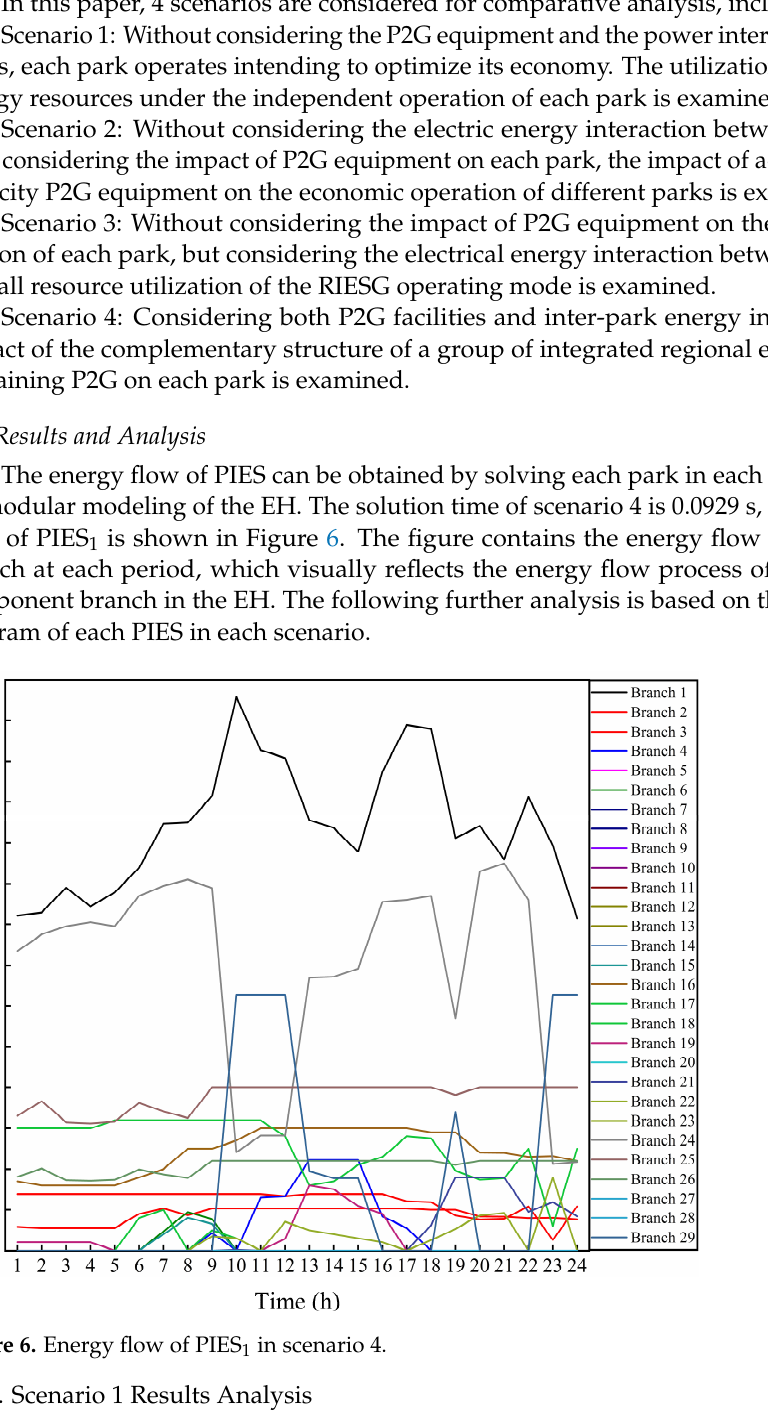
Figure 7. Power surplus and shortage of each PIES. As can be seen in Figure 7, PIES 1 has a large surplus of renewable energy to meet its own load demand, due to the abundant wind and solar resources inside the park. It is worth noting that the surplus renewable energy cannot be consumed under the independ- ent operation mode. PIES 2 is a single wind power generation system, and PIES 3 is a single photovoltaic power generation system. Since the renewable energy resources in the park are inadequate to supply the energy demand of the system itself, the situation reflects the time difference of scenery resources, in which PIES 2 is a wind power generation system, and the power shortage is larger in the daytime when the wind power generation is small, and PIES 3 is a photovoltaic power generation system, and the power shortage is larger at night. PIES 4 is a combination of wind and solar power generation systems. As the shortage of renewable energy resources in the park is still available, a small amount of external grid is required to cover up the shortage several times, and occasionally a small amount of surplus is not utilized. The results of the independent operation of the four PIESs reflect